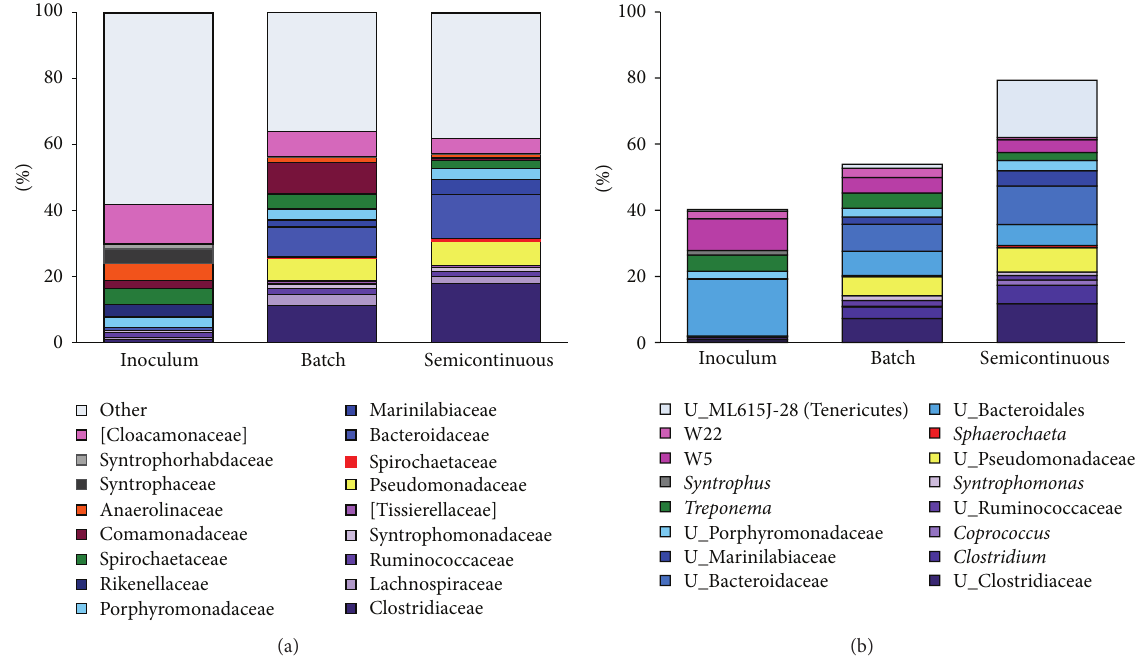
Figure 4: Bacterial distributions. (a) Phylotypes at the family level. (b) Most abundant phylotypes at the genera level. Similar colors (purple, yellow, black, blue, green, gray, and pink) indicate that the families are in the same order. The total NH 3 -N concentration at the time of the batch sampling was 1140mg/L. Semicontinuous operation is an average of two samples at ∼ 2000 mgNH 3 -N/L. “U ” stands for unidentified microorganism within the taxonomic classification.